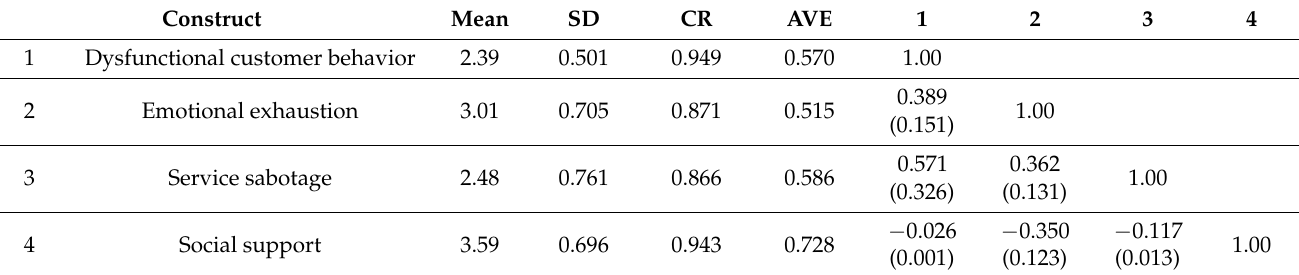
Table 3. Descriptive statistics and associated measures.